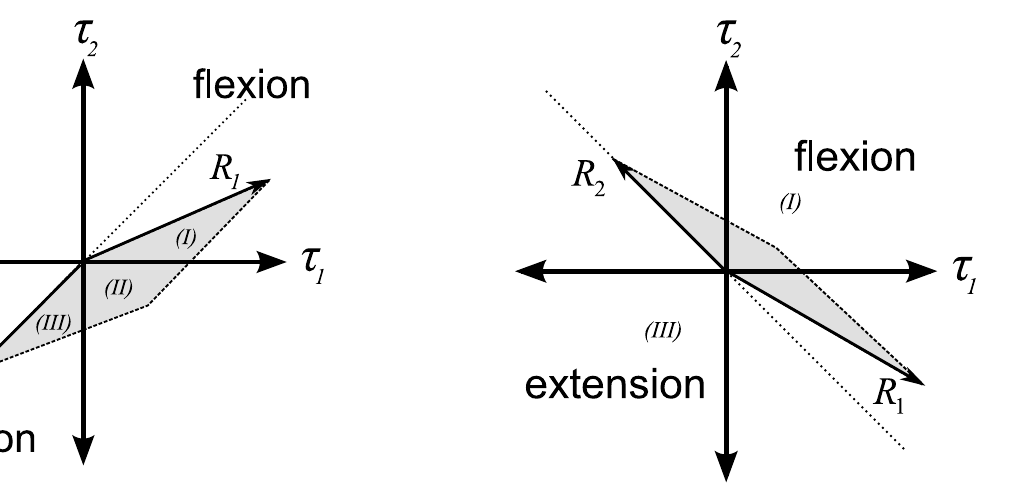
Figure 6. A di ff erent tendon arrangement can produce undesirable results. In this case, both joints cannot be extended simultaneously.